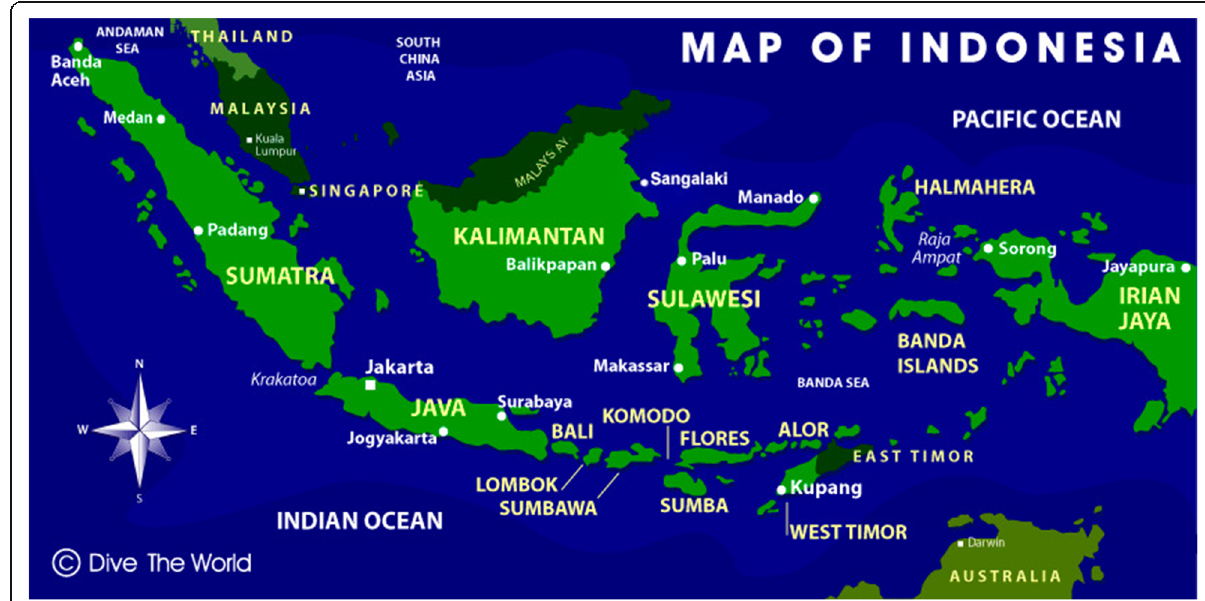
Fig. 1 The map of Indonesia locating the Madura Island (pointed by red arrow) and other geographically isolated islands with bio diversified ethnicities. Retrieved from